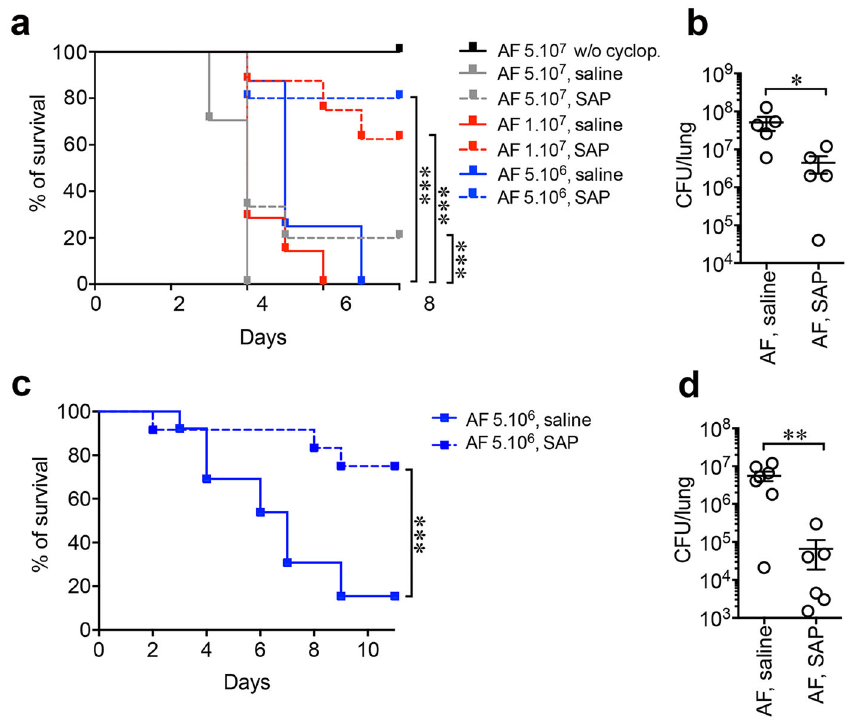
Fig. 6 Therapeutic ef fi cacy of SAP against invasive aspergillosis in immunosuppressed hosts. a Percent survival of transiently immunosuppressed wt mice after i.t. injection with the indicated doses of AF conidia. The curve of untreated mice ( n = 3) with cyclophosphamide is also shown. Human SAP (4 mg/kg) was i.p. injected at 2 h and 24 h after infection. AF 5 × 10 7 , n = 17 mice; AF 5 × 10 7 + SAP, n = 15 mice; AF 1 × 10 7 , n = 7 mice; AF 1 × 10 7 + SAP, n = 8 mice; AF 5 × 10 6 , n = 8 mice; AF 5 × 10 6 + SAP, n = 10 mice. An independent experiment shown. SAP-treated vs. saline, P = 0.002, AF 5 × 10 7 ; P = 0.001, AF 1 × 10 7 ; P = 0.004, AF 5 × 10 6 (Log-rank, Mantel-Cox test). b Lung CFU in mice treated with cyclophosphamide and infected with 1 × 10 7 AF conidia. N = 5 AF, n = 5 AF + SAP. Mean ± SEM of an independent experiment. * P = 0.02 (two-sided, Mann – Whitney U -test). c , d Effect of local administration of SAP on survival ( c ) and lung CFU ( d ) after i.t. injection of 5 × 10 6 in wt mice treated with saline (50 µ l/mouse; n = 13) or human SAP (50 µ g/50 µ l/mouse; n = 12) 2 h after infection. *** P = 0.003 (Log-rank, Mantel-Cox test). c One experiment shown out of 2 performed with similar results. d Each spot corresponds to a single mouse. Mean ± SEM of an independent experiment. ** P = 0.008 (two-sided, Mann – Whitney U -test).